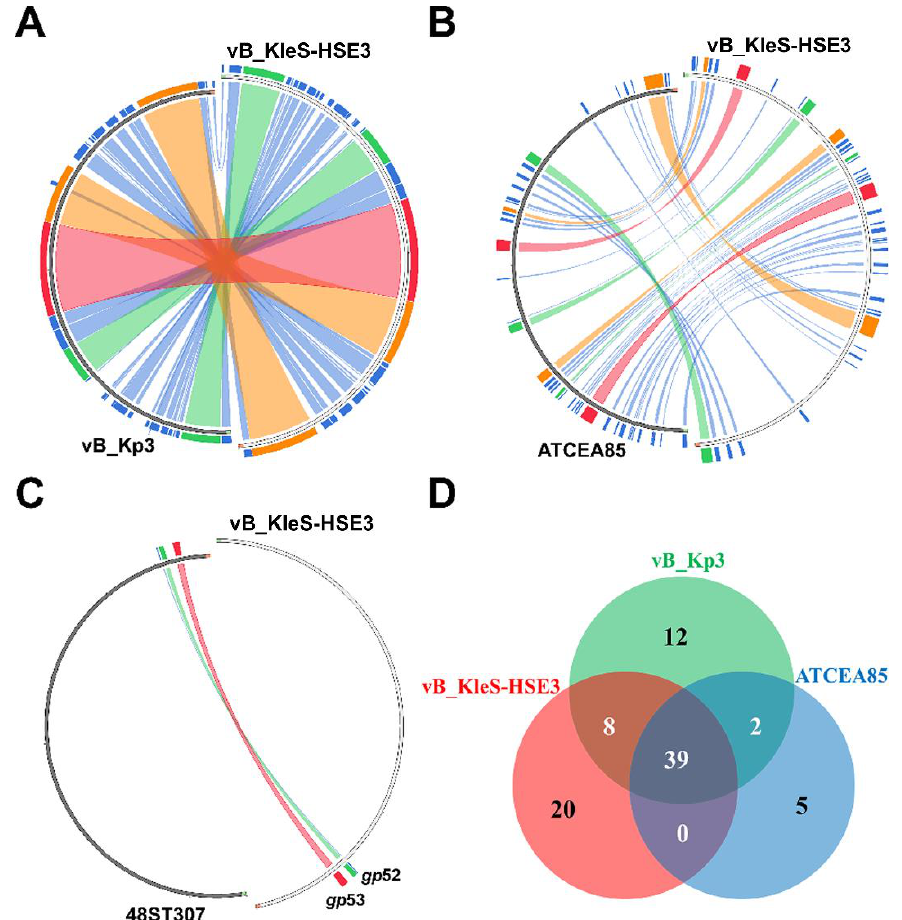
Figure 5. Comparative genomic analysis of the Klebsiella vB_KleS-HSE3 phage. The genome sequence of the Klebsiella vB_KleS-HSE3 phage was compared with that of the Klebsiella phage vB_Kp3 ( A ), ATCEA85 ( B ), and 48ST307 ( C ). The results were visualized using Circoletto, and the similar genome regions are shown in the same color. ( D ) The core gene analysis of Klebsiella phage vB_KleS-HSE3, vB_Kp3, and